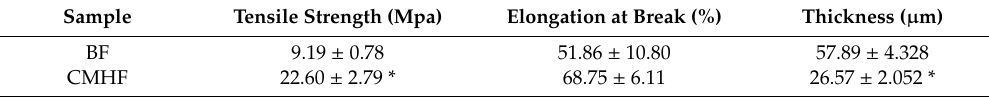
Table 5. Stress, elongation at break, and average break time of BF and CMHF films. Sample